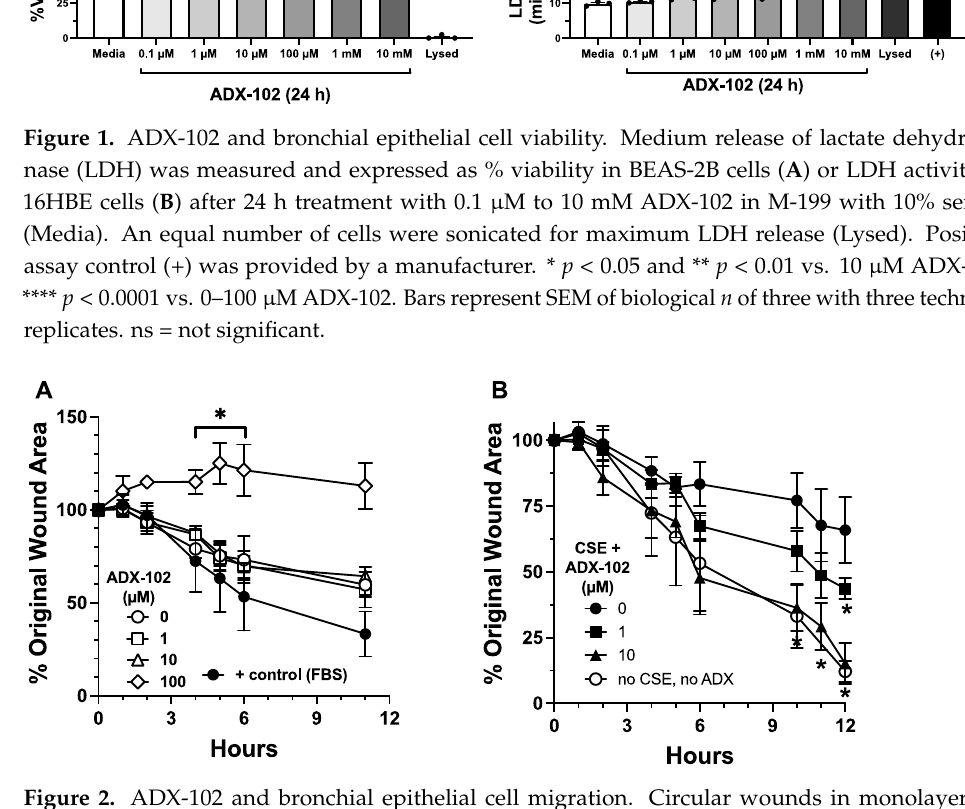
Figure 2. ADX-102 and bronchial epithelial cell migration. Circular wounds in monolayers of BEAS-2B cells were measured for cell migration into the wound area in the presence of 0–100 µ M ADX-102 over time ( A ). Positive control for wound closure was M-199 with 10% serum (FBS). In panel ( B ), BEAS-2B cells were wounded in the presence of 5% cigarette smoke extract (CSE) and in the presence of 0–100 µ M ADX-102, and % wound closure was measured. * p < 0.05 vs. 0 µ M ADX-102. Bars represent SEM of n = 5, each with three